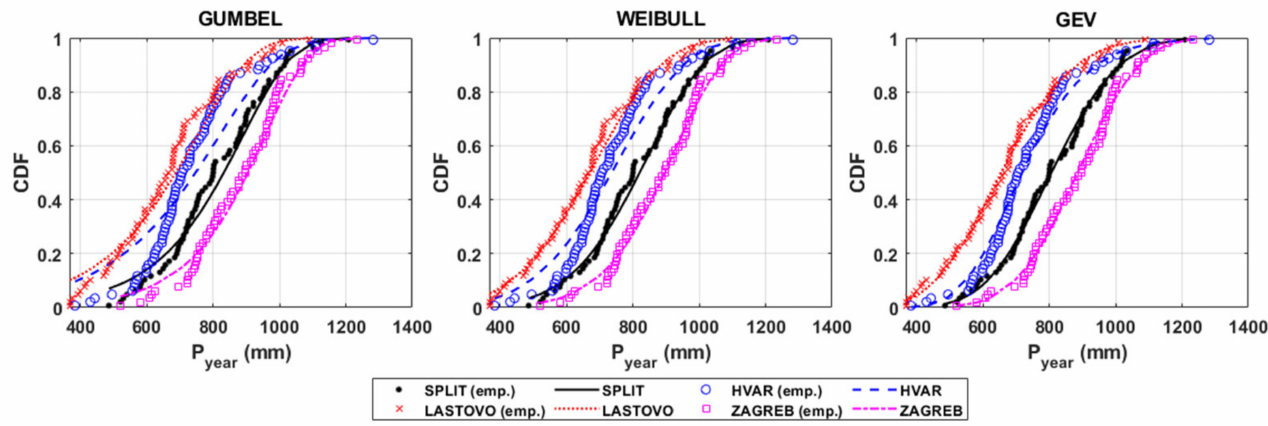
Figure 3. Cumulative distribution functions of the annual precipitation values for the four measuring stations, determined with Gumbel, Weibull and GEV